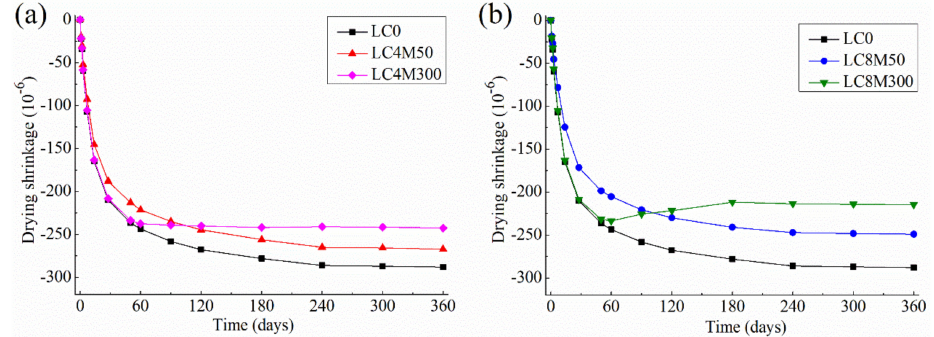
Figure 4. Drying shrinkage of LHP concrete containing two kinds of MgO at a dosage of ( a ) 4% and ( b )